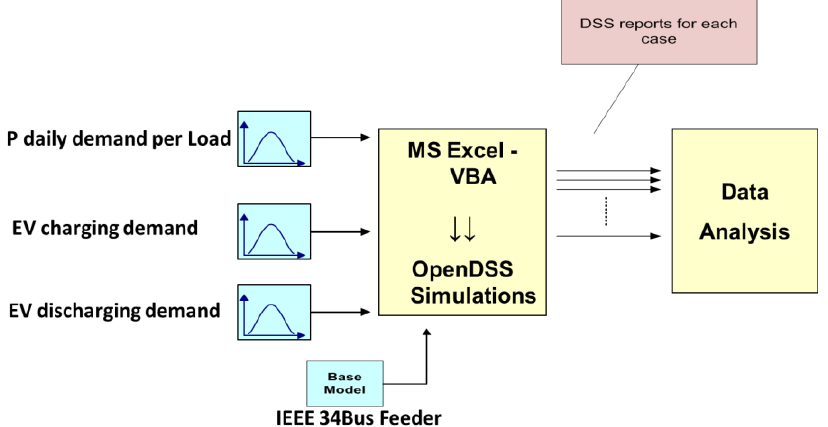
Figure 4. Study Simulation Block Diagram.